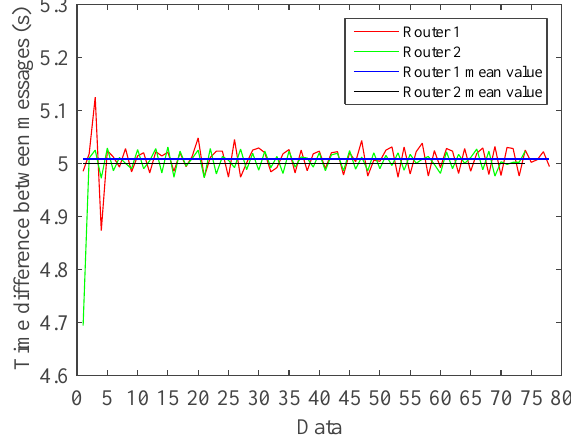
Figure 16. Case A.2: Time intervals between the data points received.